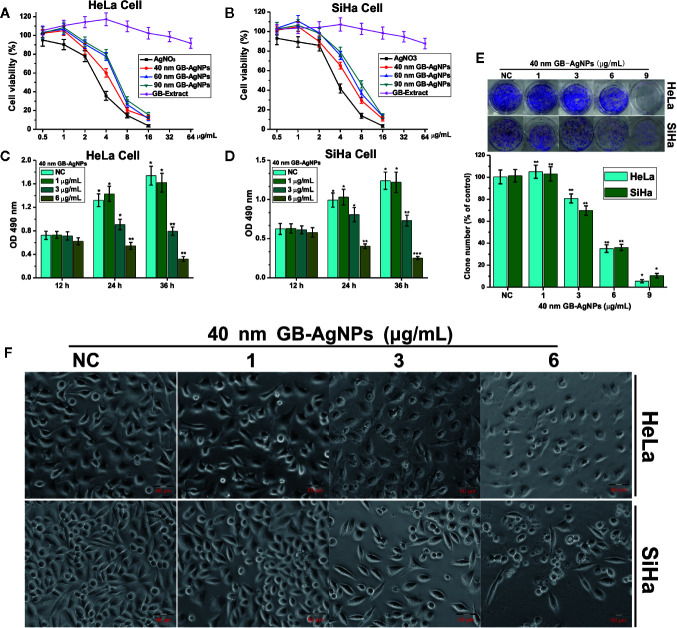
Ginkgo extract synthesized silver nanoparticles (GB-AgNPs) inhibit the proliferation of cervical cancer cells. (A, B) HeLa and SiHa cells were treated with different sizes of GB-AgNPs or AgNO3 or GB-Extract for 24 h, and cell viability was measured with an MTT assay; (C, D) HeLa and SiHa Cells were treated with indicated concentrations of 40 nm GB-AgNPs for 12, 24, and 36 h, and MTS-incorporating live cells were detected with an MTS proliferation assay; (E) Cells were treated with indicated concentrations of 40 nm GB-AgNPs for 14 days, and live cells were detected with a colony formation assay; (F) cells were treated with indicated concentrations of 40 nm GB-AgNPs for 24 h, cell morphology was observed under an inverted phase-contrast microscope and images were obtained. Data are expressed as the means ± SD; *P < 0.05, **P < 0.01, ***P < 0.001.